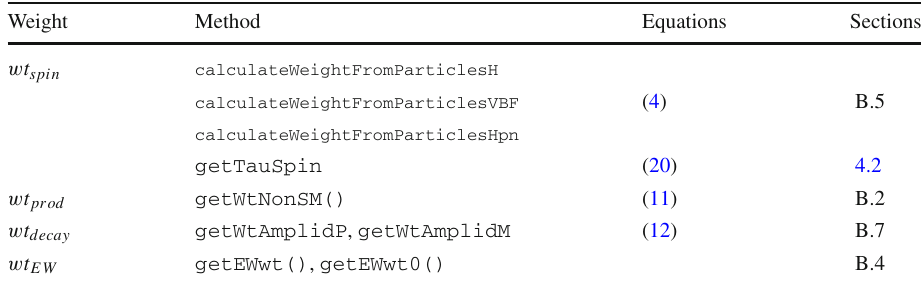
Table 4 Weights of the TauSpinner methods of calculation and Appendices explaining examples of their